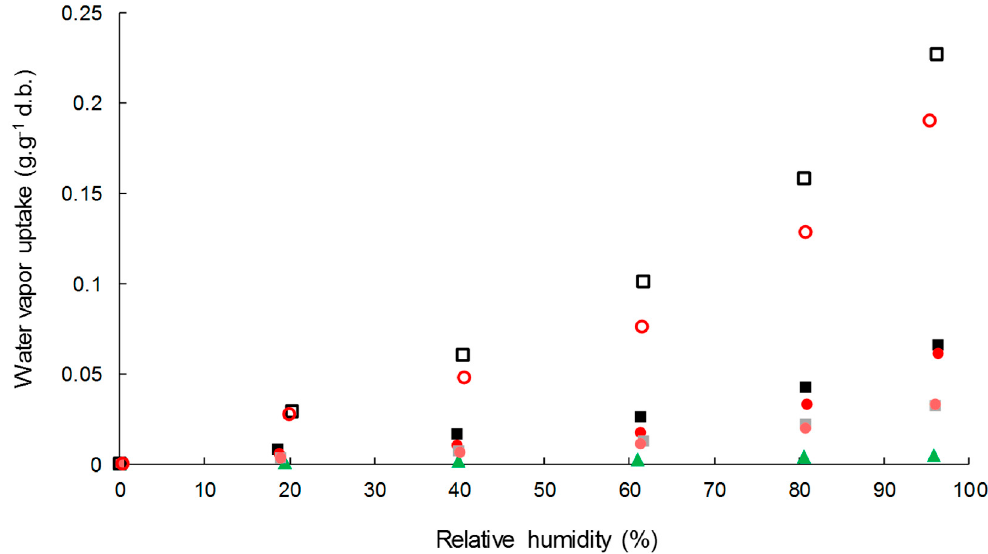
Figure 4. Water vapor sorption isotherm of C-virgin ( □ ), C-grafted ( o ), PHBV ( ▲ ), PHBV-20VC ( ■ ), PHBV-20GC ( • ), PHBV-33VC ( (cid:4) ) and PHBV-33GC ( • PHBV-20GC ( ● ), PHBV-33VC ( ■ ) and PHBV-33GC ( ● ).